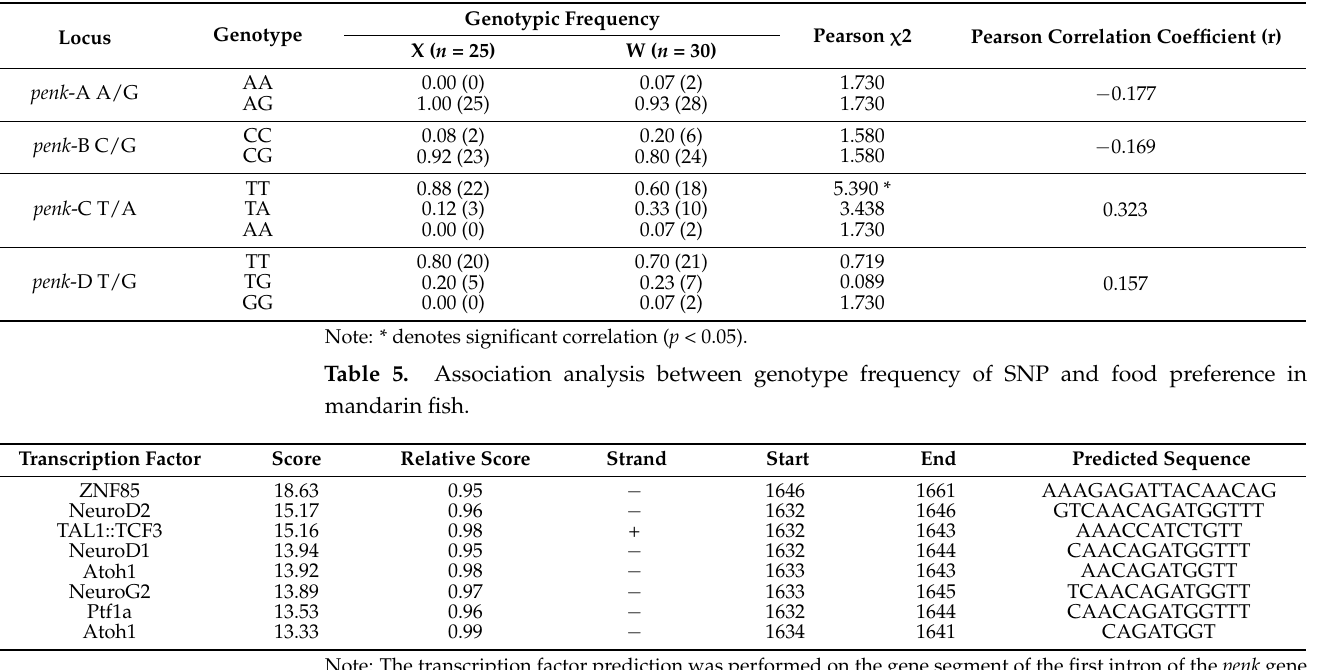
Table 4. Association analysis between genotype frequency of SNP and food preference in mandarin fish.